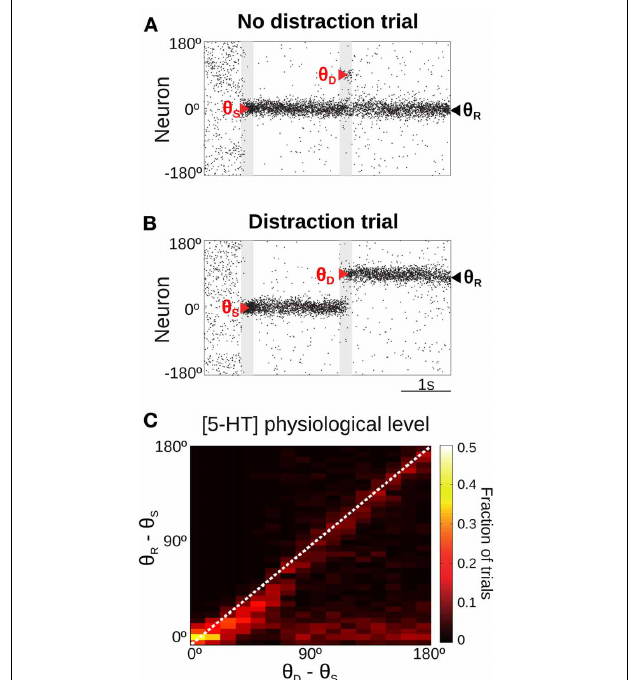
FIGURE 4 | Only for distant intervening distractors can the network model resist distraction. (A,B) Rastergram during a simulated SWM task with a distractor. Transient cue presentation of 250ms (first gray bar) centered at angle θ S (first red triangle) induces a tuned sustained memory state, which could be maintained (A) or not (B) after the presentation of a distractor (second gray bar) of the same duration and intensity as the cue, but in a different position θ D (second red triangle). The report location ( θ R , black triangle) is decoded from activity at the end of the delay period. (C) For the physiological level of [5-HT], fraction of simulation trials in which a given distraction angle θ R − θ S was observed when stimulus and distractor were presented at different relative locations θ D − θ S ( θ S = 0 ◦ , θ D from 0 to 180 ◦ in steps of 11.25 ◦ , 100 simulations per θ D ). Warmer colors on the diagonal indicate distraction, while resistance to distractors is characterized by higher fraction of trials (warmer colors) along the x